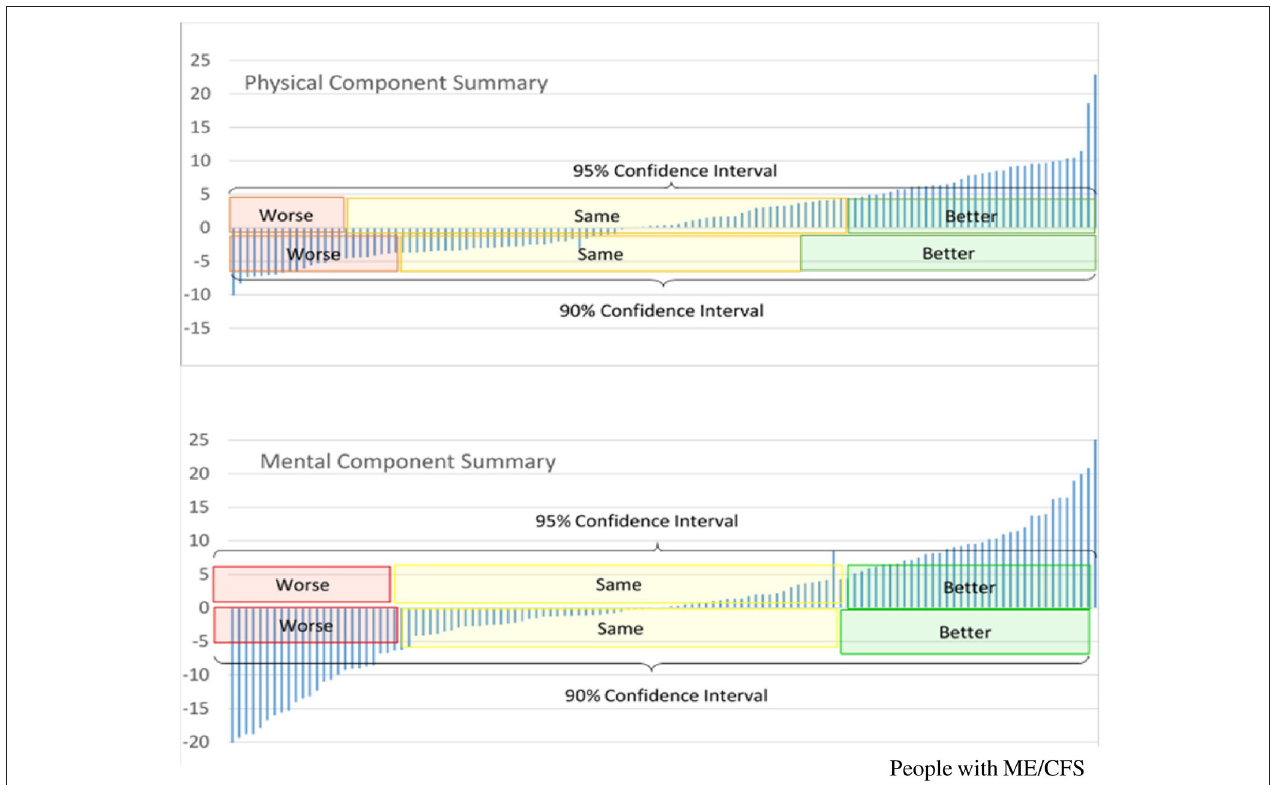
FIGURE 1 | Longitudinal changes in SF-36v2 TM Component Summary scores, in people with ME/CFS who participate in the UK ME/CFS Biobank, between baseline and first follow-up*. *First follow up occurred between 6 and 12 months from baseline, Y-axis represents difference in scores between first follow-up assessment and baseline assessment; positive values indicate scores are higher at follow-up assessment, and therefore represent improvement. PCS, Normalized Physical Component Summary scores from SF-36v2 TM ; MCS, Normalized Mental Component Summary score from SF-36v2 TM